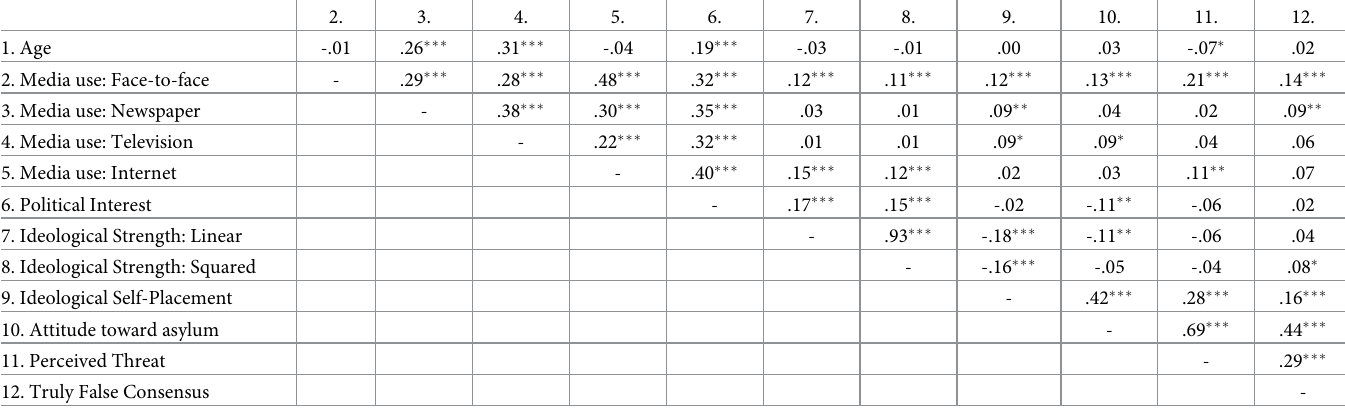
Table 2. Intercorrelations between main